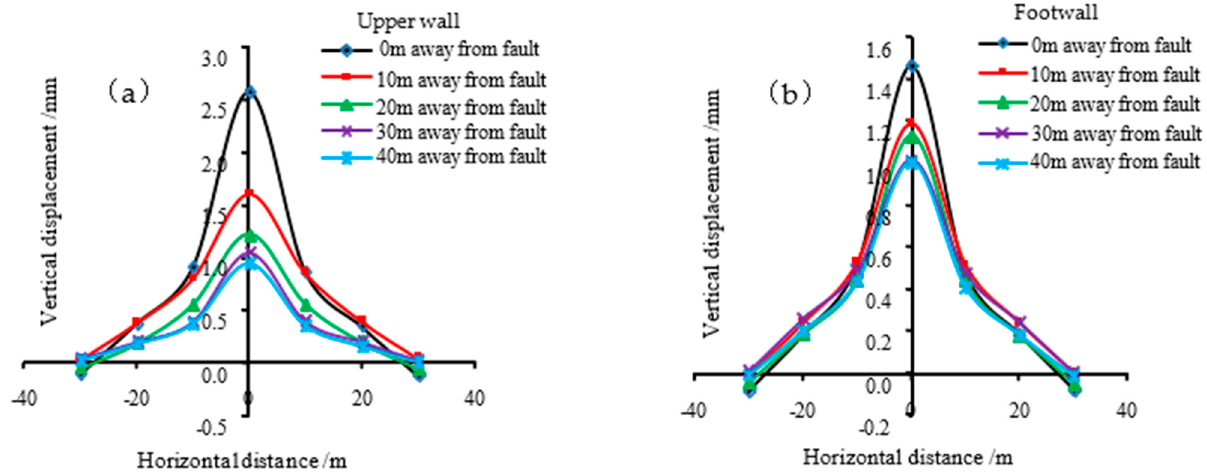
Figure 10. Vertical displacement distribution curves of surface soil at different distances from the fault and perpendicular to the high-speed railway line. ( a ) At different distances of the upper wall; ( b ) at different distances of the footwall.